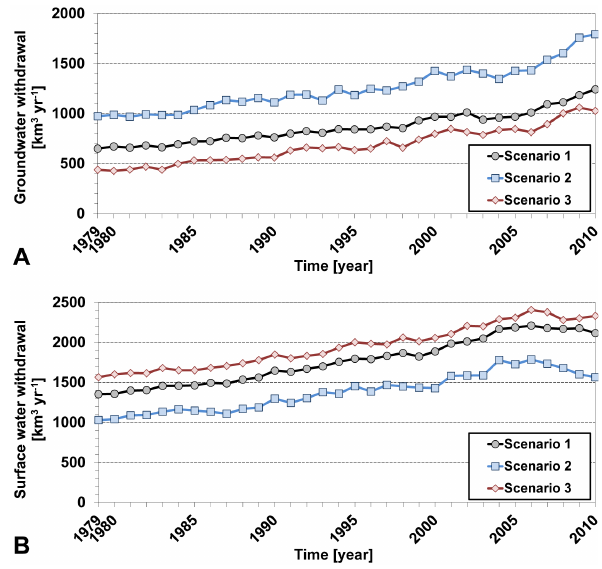
Fig. 7. Comparison of simulated monthly TWS anomalies with those of the GRACE observations [m] for selected major basins over the period 2003–2010. The results were obtained from the mean of the simulation with the ERA-Interim and MERRA cli- mate. Black solid line, blue dashed line, and red dashed line indicate the GRACE observation, pristine condition (natural climate vari- ability only), and human-induced change (water use and reservoir operations), respectively. Monthly GRACE terrestrial water storage anomaly data were obtained from the DEOS Mass Transport release 1/1b (DMT-1) model (Liu et al., 2010).